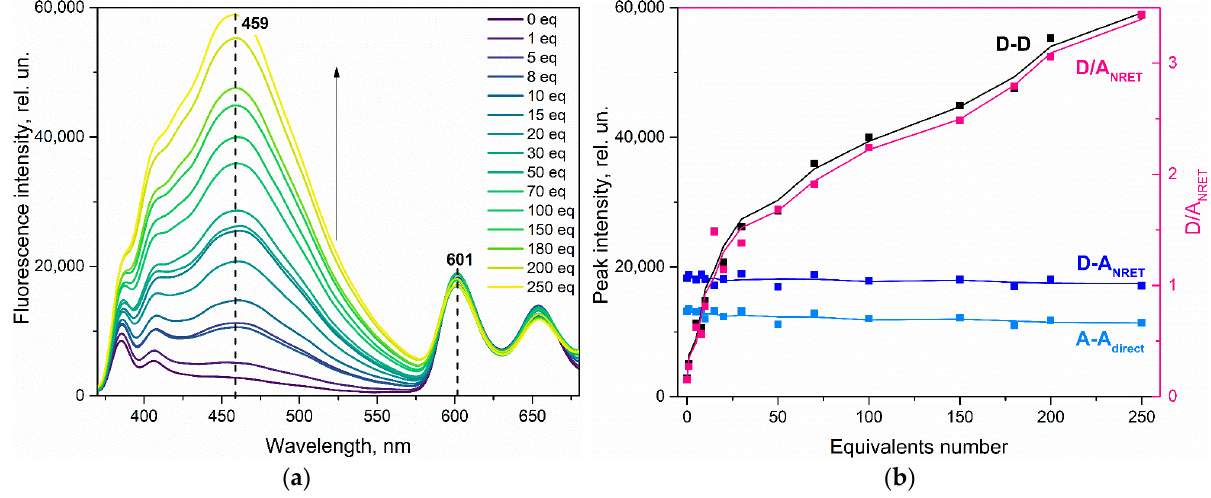
Figure 6. ( a ) The fluorescence titration of ZnPIP (7.3 × 10 − 7 M) with NB (0–250 eq) in toluene ( λ ex = 346 nm). ( b ) The calibration plot for ZnPIP response to NB : D-D curve for the intrinsic D emission under λ ex = 346 nm, A-A direct for the intrinsic A emission under λ ex = 550 nm, D-A NRET for the A emission under λ ex = 346 nm, D/A NRET for the ratio between D-D and D-A NRET curves.